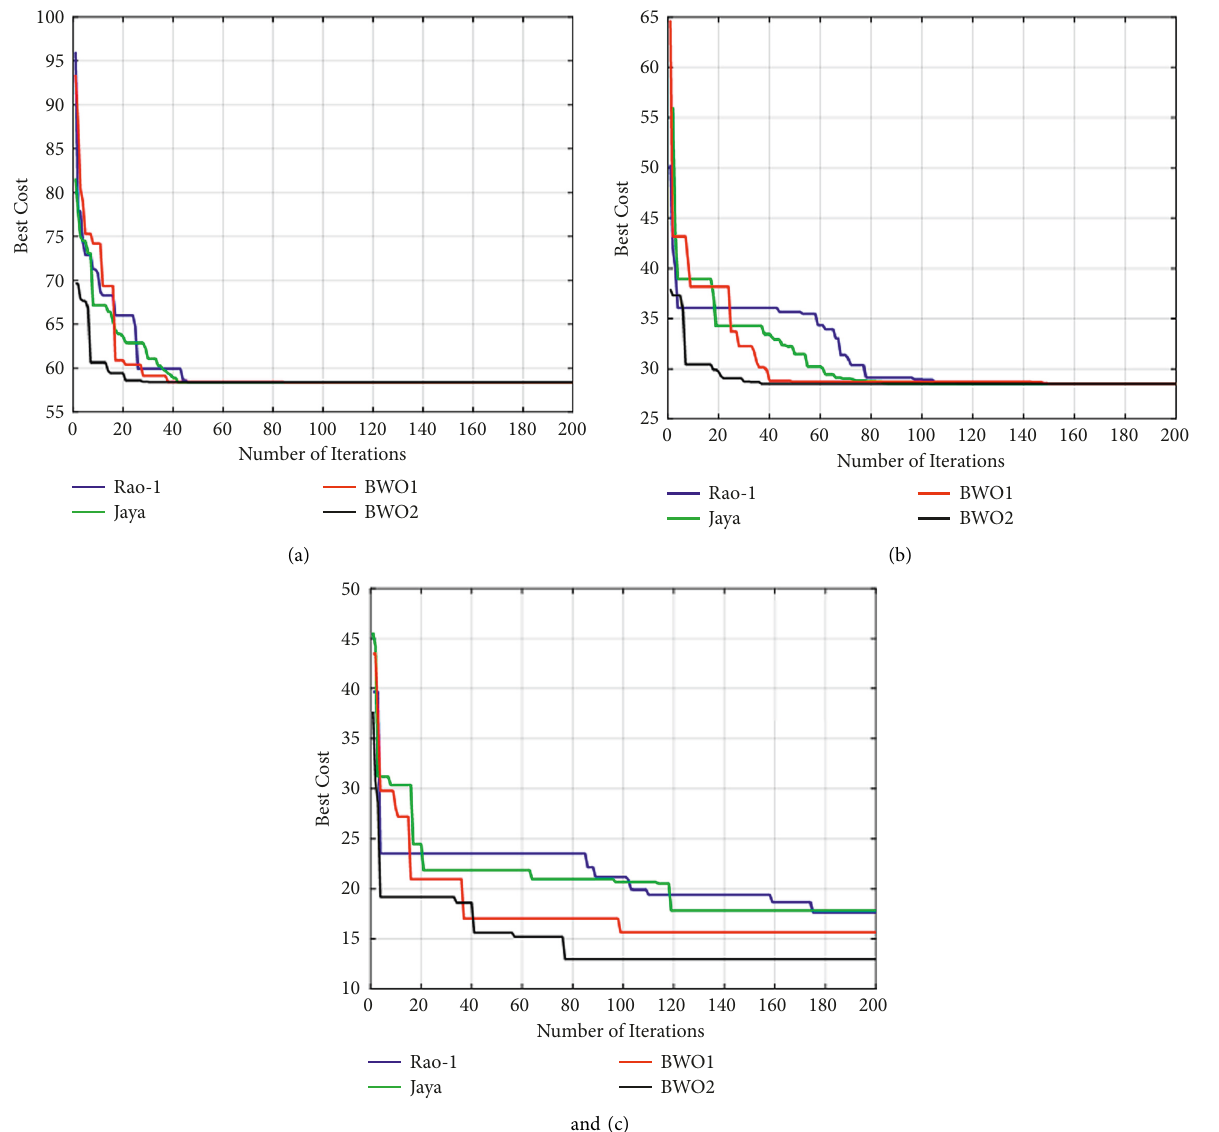
Figure 19: Convergence characteristics of Rao-1, Jaya, BWO-1, and BWO-2 for the 33-bus test system for simultaneous allocation of (a) 1DG and 1SC, (b) 2DGs and 2SCs, and (c) 3DGs and